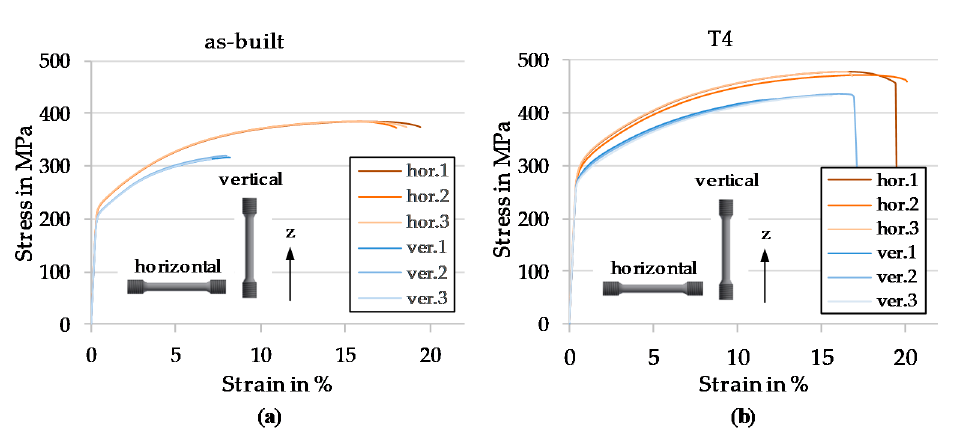
Figure 15. Stress strain curves ( a ) as built ( b ) T4 heat treated.